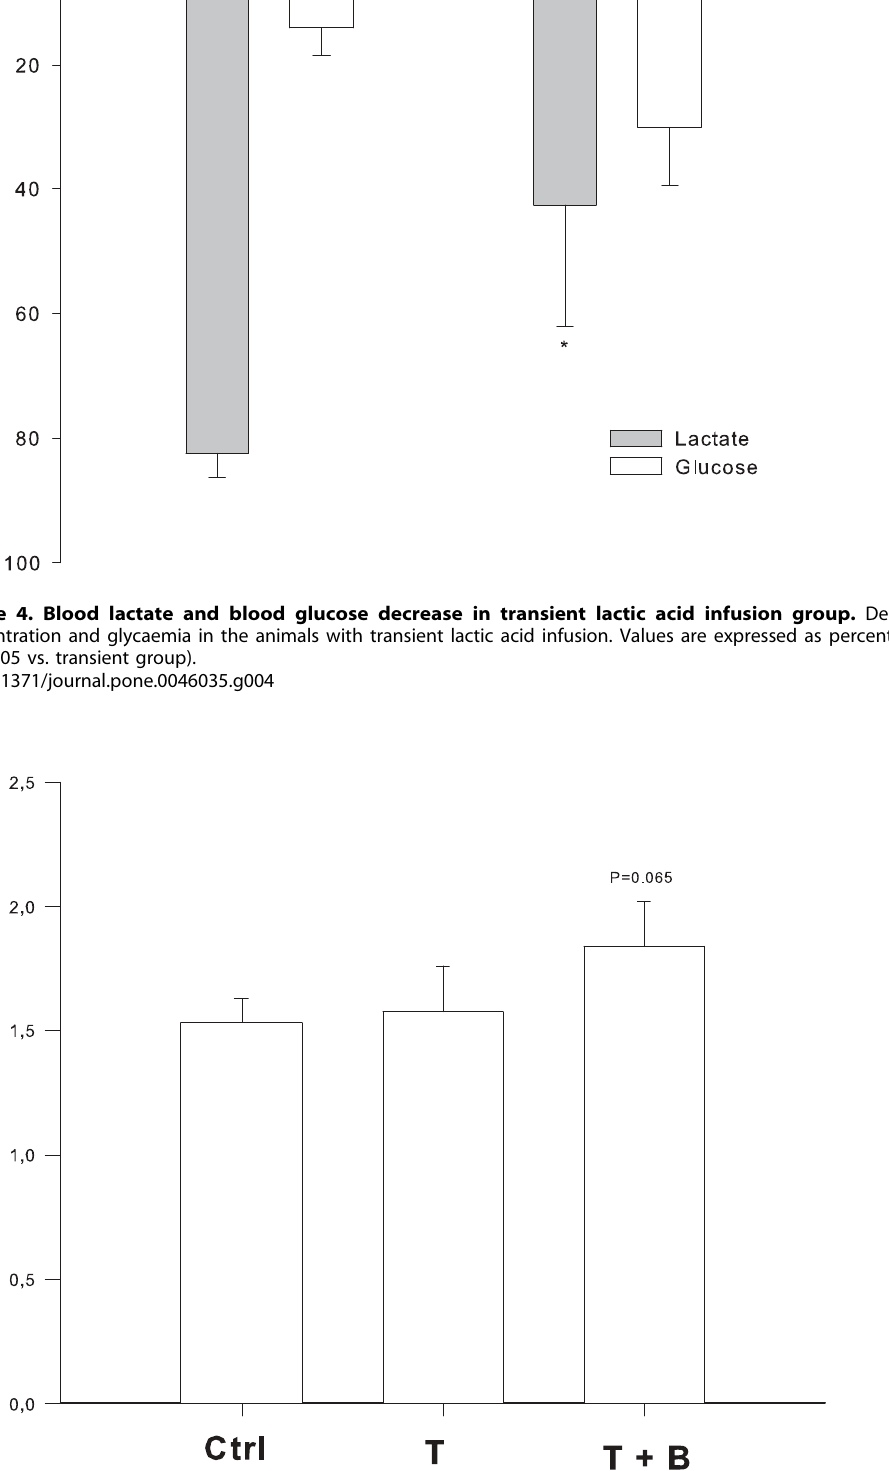
PLOS ONE | www.plosone.org 7 September 2012 | Volume 7 | Issue 9 |